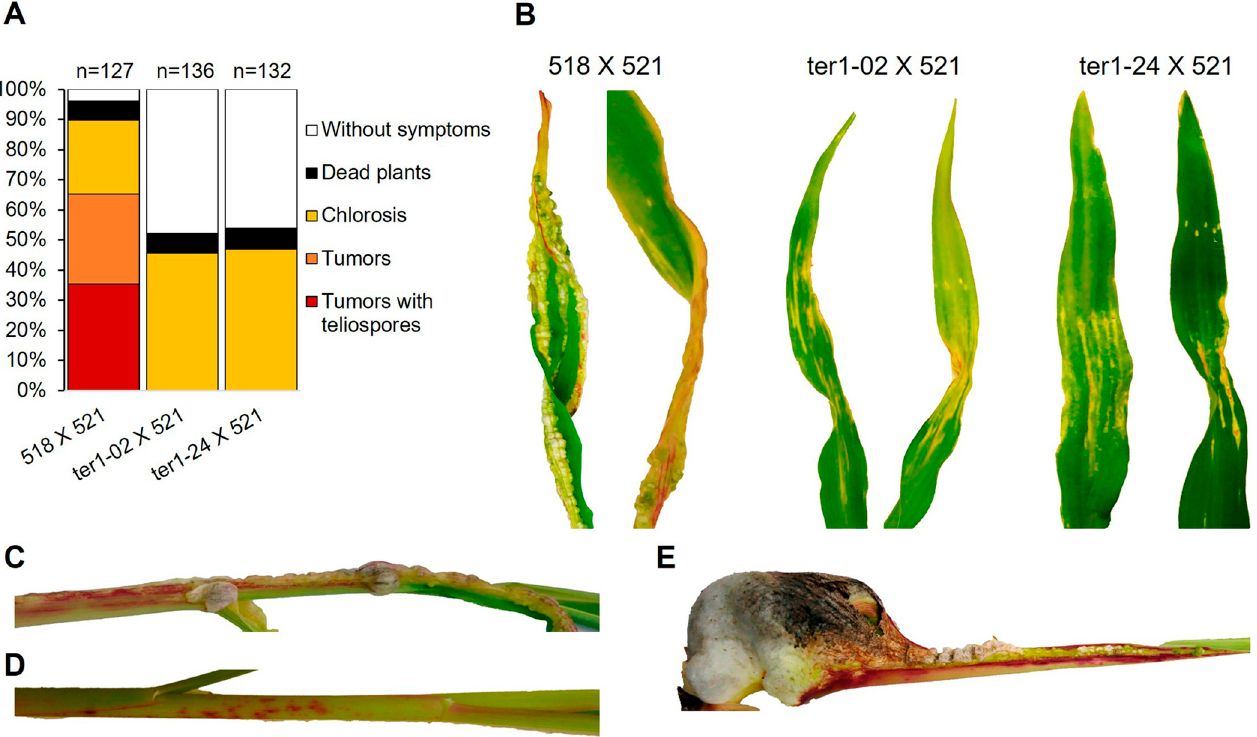
Fig 7. Development of infection in maize plants. (A) Quantification of symptoms in maize plants infected with the indicated crosses at 21 dpi. The mean values of three independent experiments are shown. (B) Details of the leaves and the stem at 21 dpi of the plants inoculated with the wild crosses and heterozygous crosses ter1 + / ter1 – . (C and D) Stem detail and anthocyanin formation at 21 dpi of plants inoculated with the wild crosses and heterozygous ter1 +/ ter1 – crosses, respectively. (E) tumor developed by wild crosses at 21 dpi.